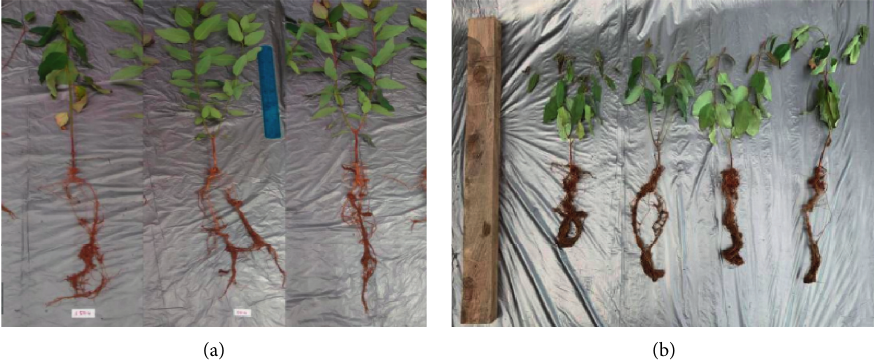
Figure 2: Above- and belowground samples of E. pellita seedlings (a) and stem cutting (b) at second